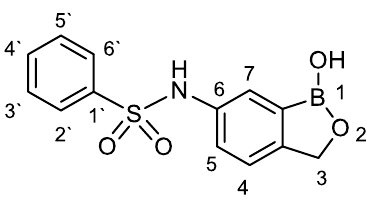
Figure 5. Structural formula of oxaborole-6-benzene sulphonamide (OXBS) derivative produced by S. atrovirens .